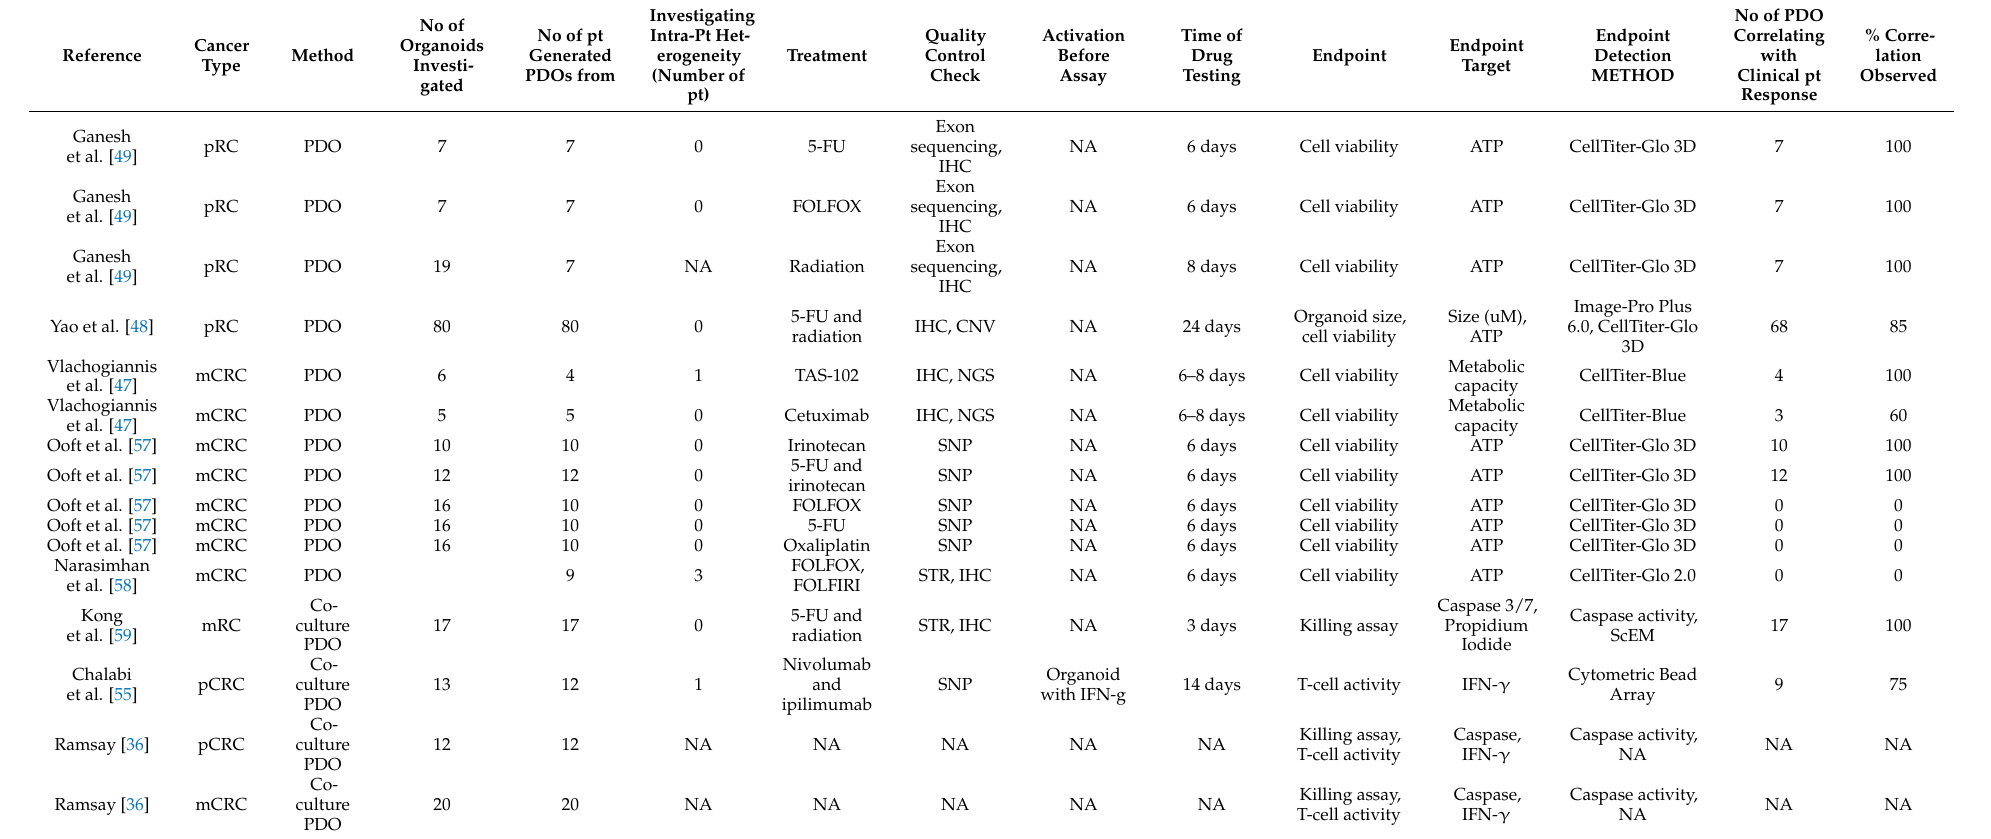
Table 1. Overview of studies correlating drug response of PDOs or co-culture PDOs with clinical outcomes in patients. pt, patient; pRC, primary rectal cancer; mCRC, metastatic colorectal cancer; mRC, metastatic rectal cancer; pCRC, primary colorectal cancer; PDO, patient-derived organoid; FOLFOX, 5-fluorouracil, and oxaliplatin; 5-FU, 5-fluorouracil; NA, not available; IHC, immunohistochemistry; CNV, copy number variation; NGS, next-generation sequencing; SNP, single nucleotide polymorphism; STR, short tandem repeat; ScEM, scanning electron